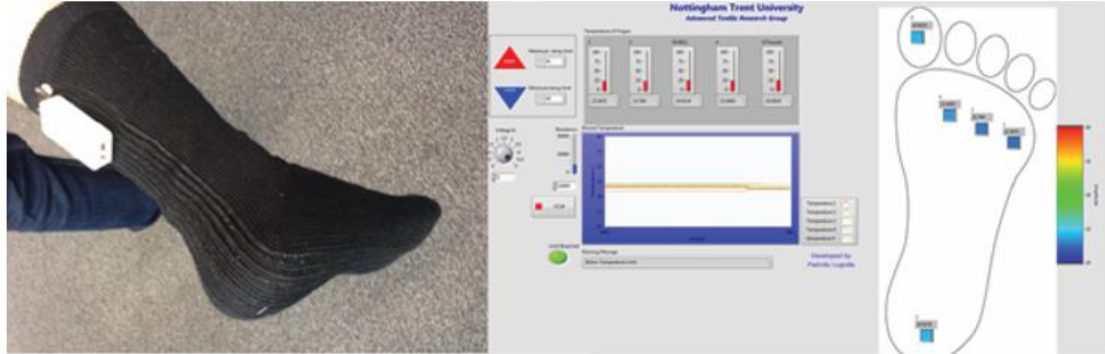
Figure 7. Prototype sock made with five electronic temperature-sensing yarns. ( Left ) Photograph of the prototype; ( Right ) Computer interface using LabVIEW. The interface shows temperature readings for five areas on the prototype garment using both numbers (not visible here) and a colour change.